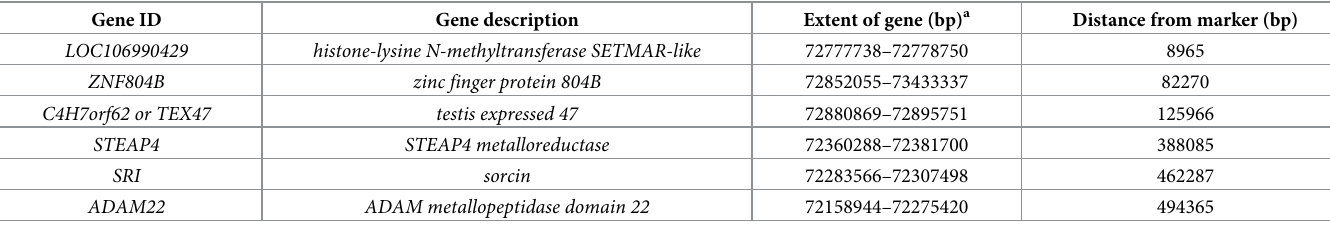
Table 2. Positional candidate genes around the s25289 . 1 significant marker on chromosome